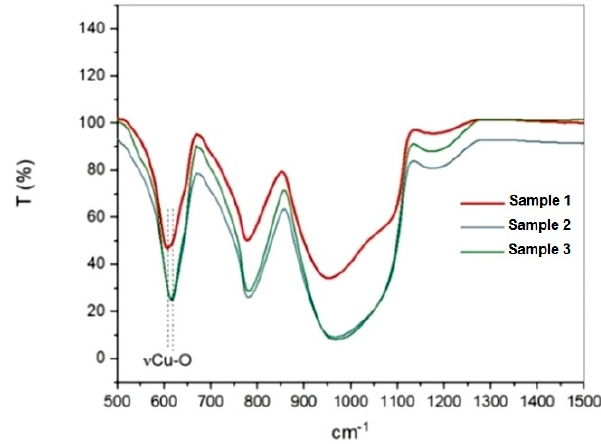
Figure 14. FTIR transmission spectra for Cu 2 O:N thin film: Sample 1, Sample 2, and Sample 3.